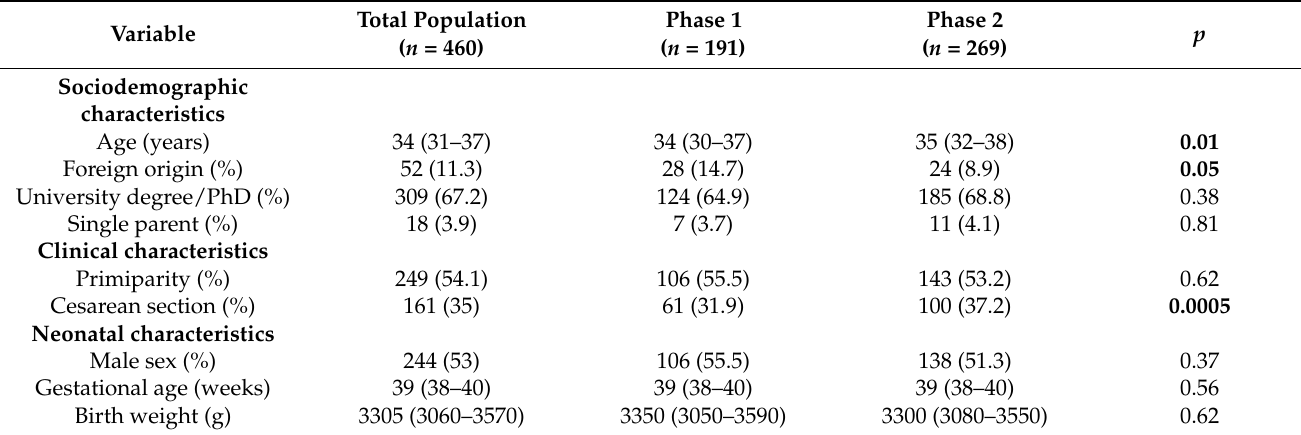
Table 2. Basic characteristics of study participants.